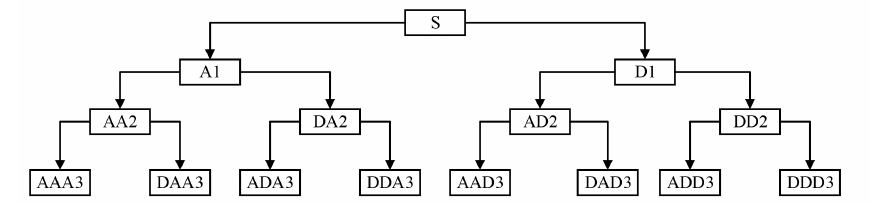
Figure 7. Structure diagram of three-layer wavelet packet